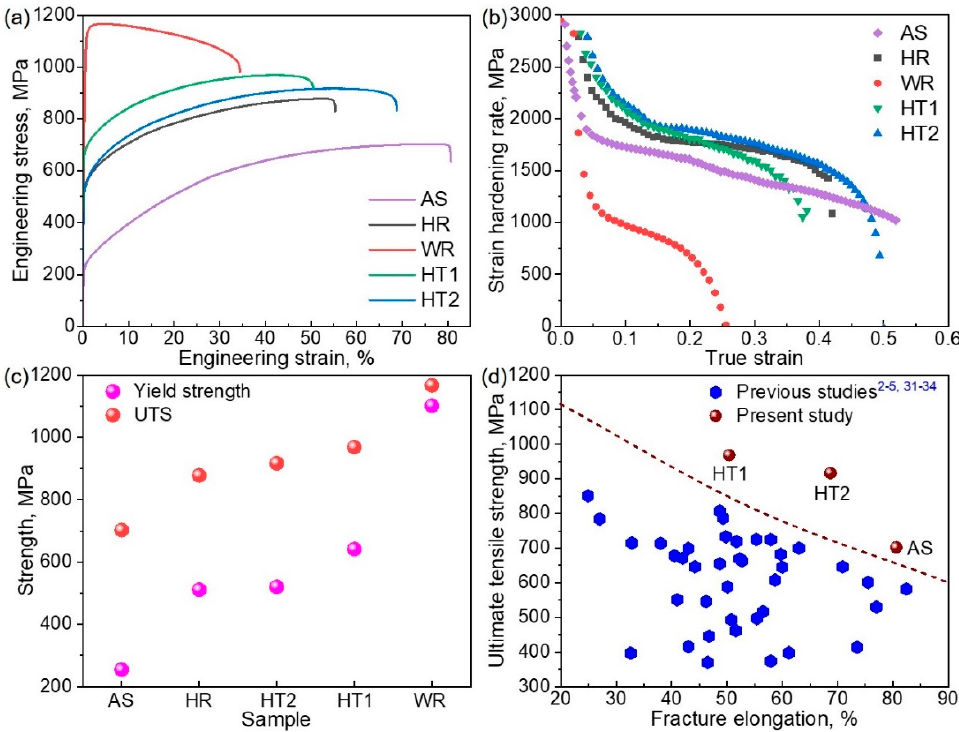
Figure 4. ( a ) Room-temperature tensile stress-strain curves, ( b ) strain hardening rate, and ( c ) statistics of the yield strength and ultimate tensile strength of the as-solutionized (AS), hot-rolled (HR), warm-rolled (WR), cold-rolled, and heat-treated at 973 K for 30 min (HT1) and heat-treated at 1023 K for 30 min (HT2) Co 35 Cr 25 Mn 15 Ni 15 Fe 10 HEAs. ( d ) Comparison of the tensile properties acquired